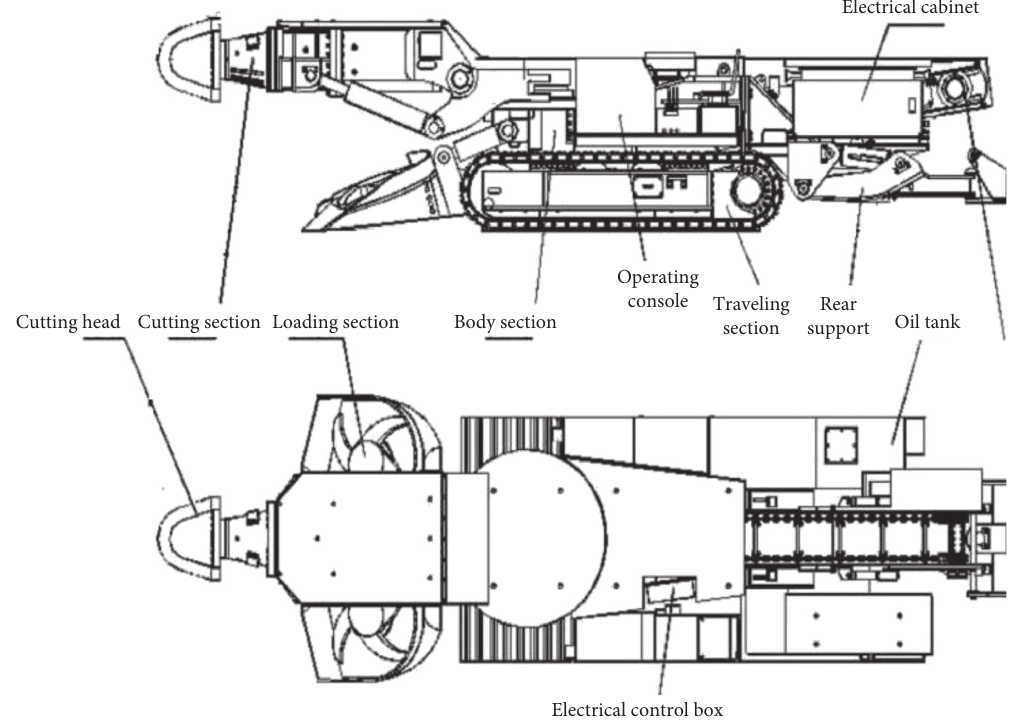
Figure 4: The roadheader.